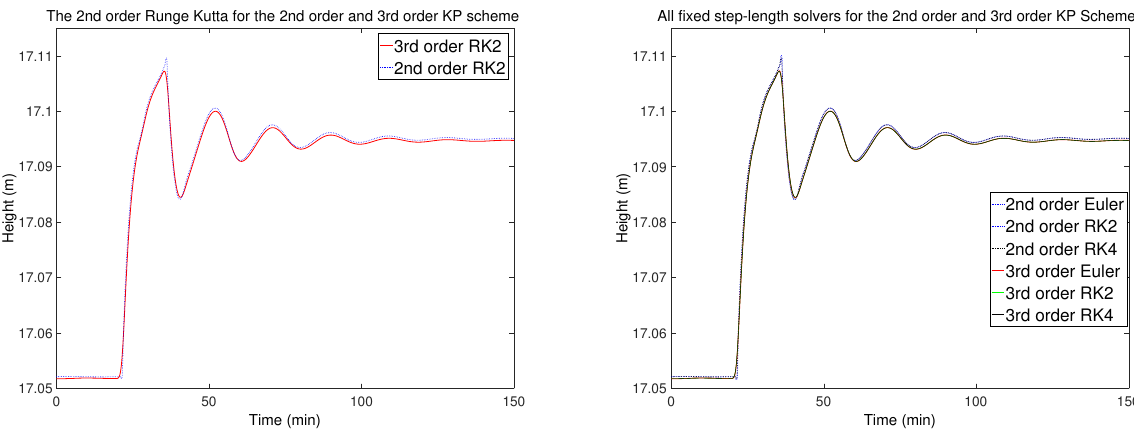
Figure 5: The RK2 method for 2 nd and 3 rd order KP scheme ( (cid:52) t = 0 . 25 s ).